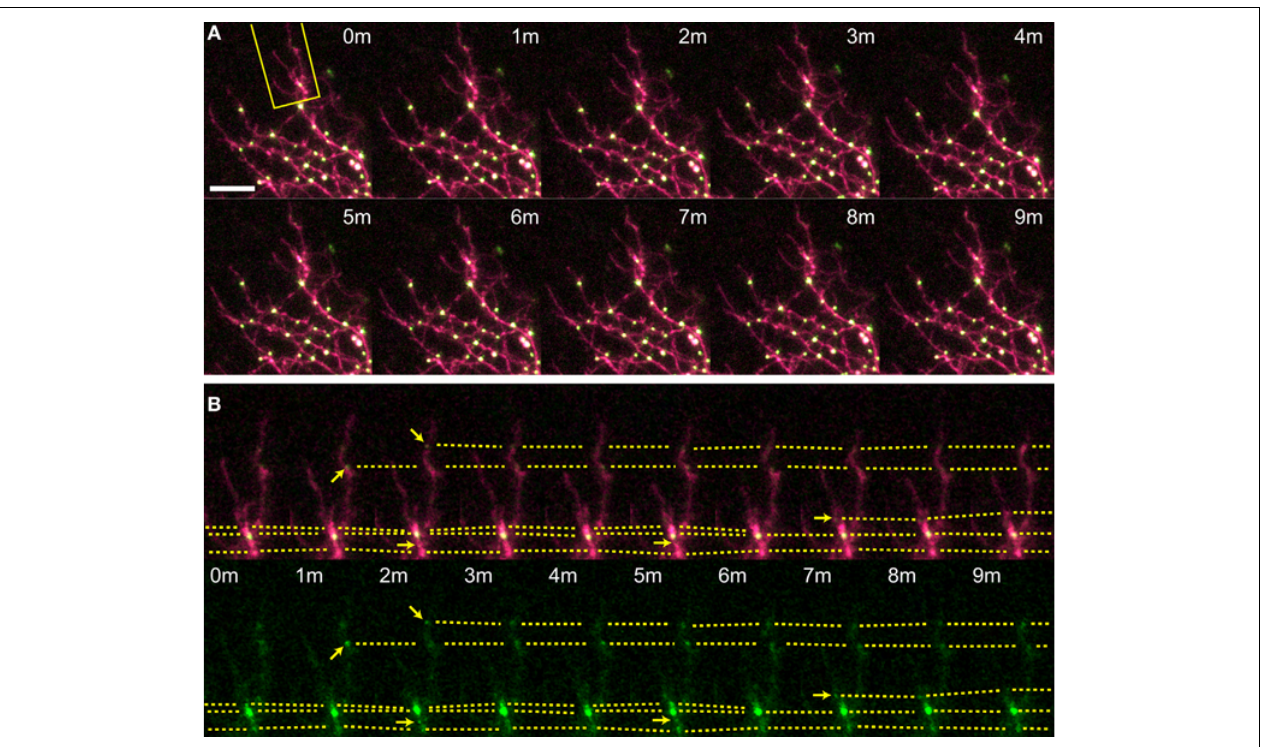
yellow shown in (B ). Arrows indicate the formation of a punctum and dotted lines follow puncta between time points and indicate puncta that fuse together and shift position. Scale bar = 10 µm. See also Supplementary Video